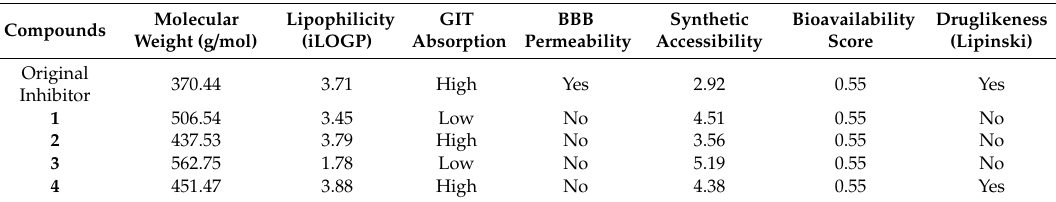
Table 4. ADME profiles of the top ranked hits. GIT and BBB stand for gastrointestinal absorption and blood – brain barrier permeability, respectively.